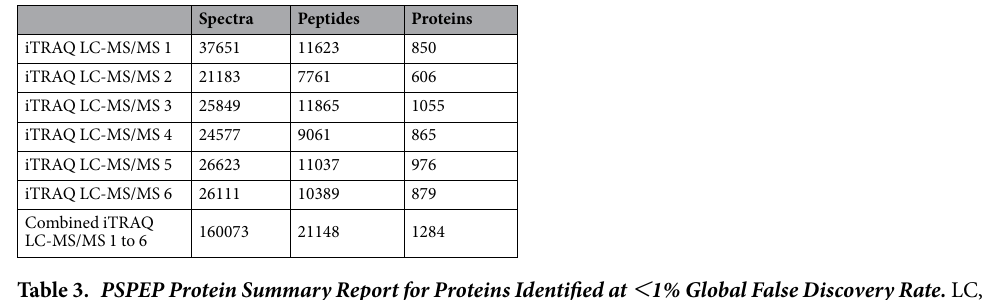
Proteins Identified by Database Search. The Protein-Pilot Proteomics System Performance Evaluation Pipeline Software (PSPEP) false discovery rate (FDR) summary showing the number of spectra, peptides and the proteins identified at 1% global FDR for the six iTRAQ experiments is shown in Table 3. Six iTRAQ liquid